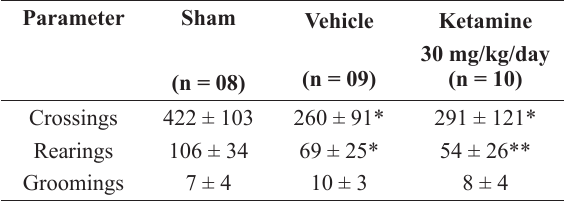
Spontaneous locomotion evaluated before the second exposition to the forced swimming (16 th